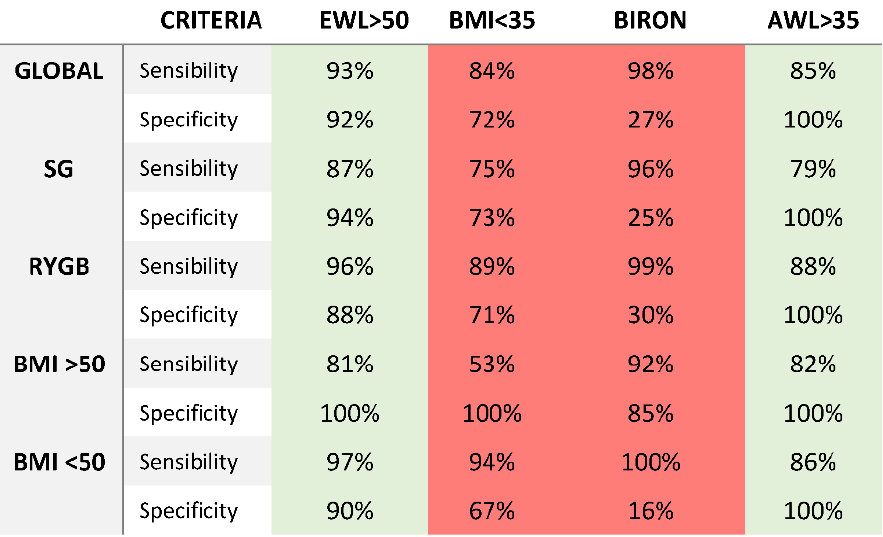
Figure 5. Sensitivity and specificity (expressed as percentages) of 4 criteria for weight loss success. Green: useful criteria with a sensitivity and specificity >70%. Red: inadequate criteria with sensitivity and specificity or specificity <60%.